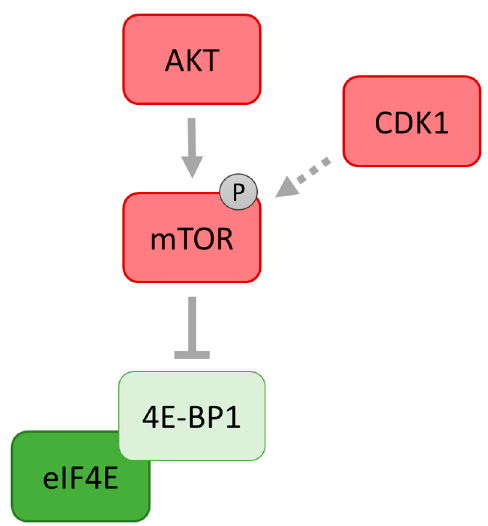
Figure 5. Cyclin-dependent kinase 1 (CDK1) participates at mTOR activation. In mitotic cells, CDK1 phosphorylates the regulatory associated protein of mTOR (RAPTOR), the key mTOR binding partner. In oocytes, CDK1 phosphorylates mTOR at Ser2448. This reinforces proposals that mTOR activity is highly regulated by CDK1 activity during cell cycle progression. Stimulatory modification is depicted as an arrow, inhibitory modification as a blunt end line. Dashed line with arrow indicates tentative stimulatory